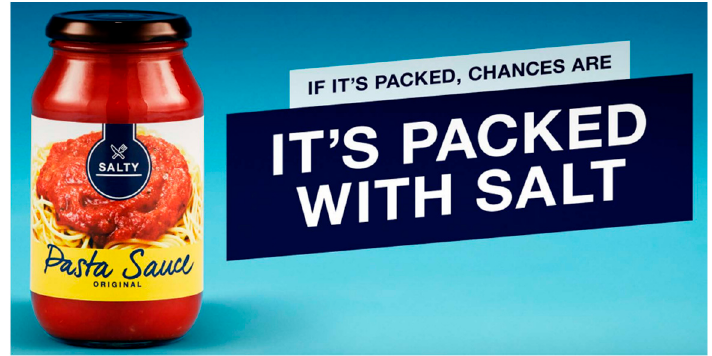
Figure 1. Advertisement used in the Unpack the Salt campaign. Table 1. Overview of campaign resources and dissemination methods [40].